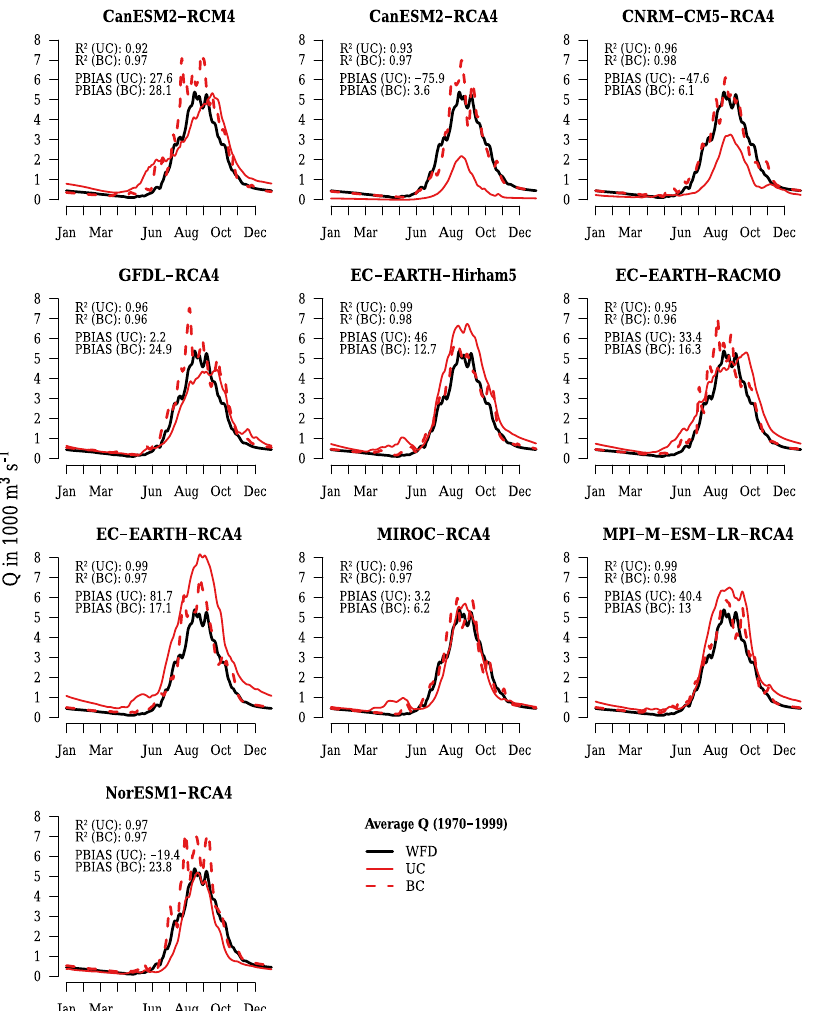
Figure 4. Annual cycle of average daily uncorrected (UC) and bias-corrected (BC) simulated discharges at gauge El Diem using regional climate model input and WATCH Forcing Data (WFD) in the reference period